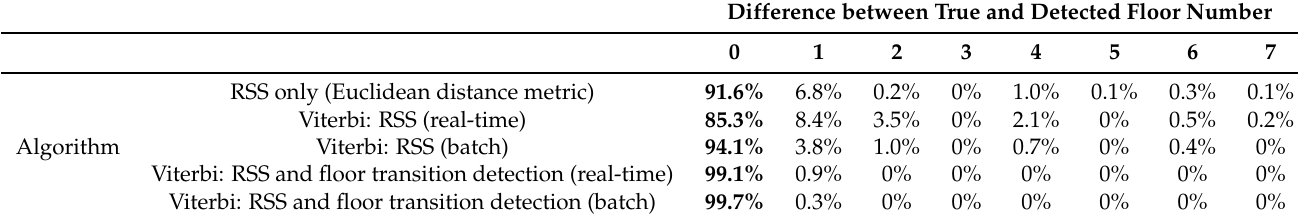
Table 5. Floor detection errors for different configurations as distance in floor numbers to the true floor. The Viterbi-based algorithm incorporating both the RSS and floor transition detections achieved the highest